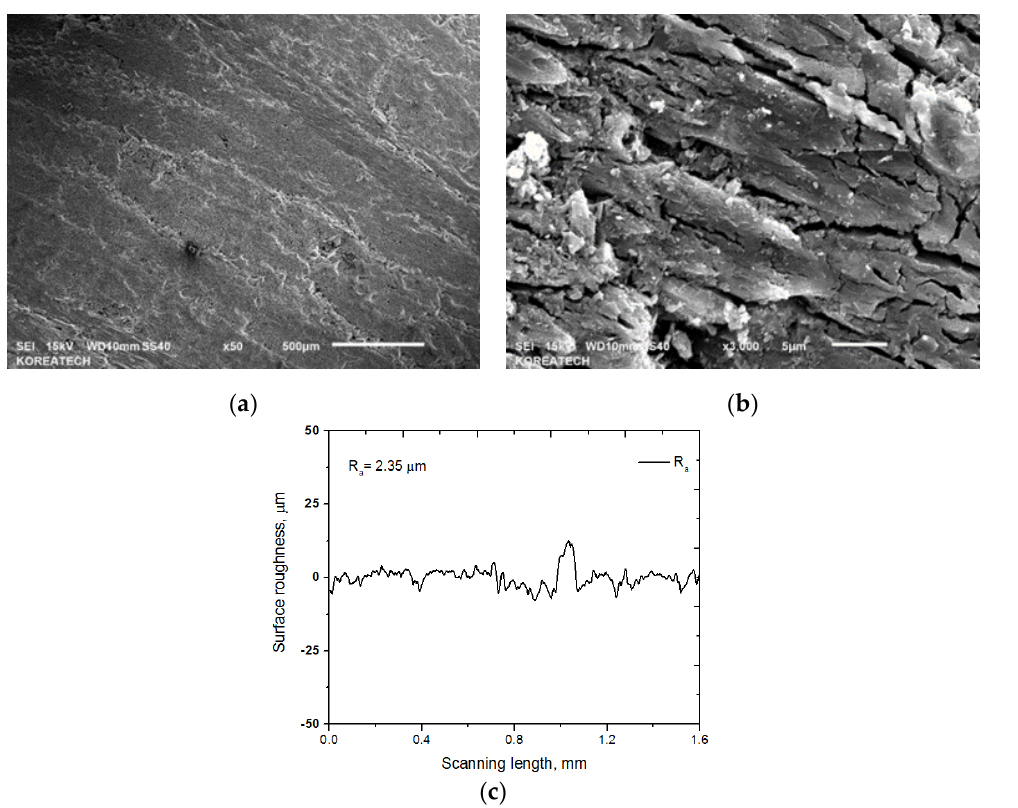
Figure 3. SEM images at low ( a ) and high ( b ) magnification, and cross-sectional surface roughness profile ( c ) of the C/C-SiC composite.